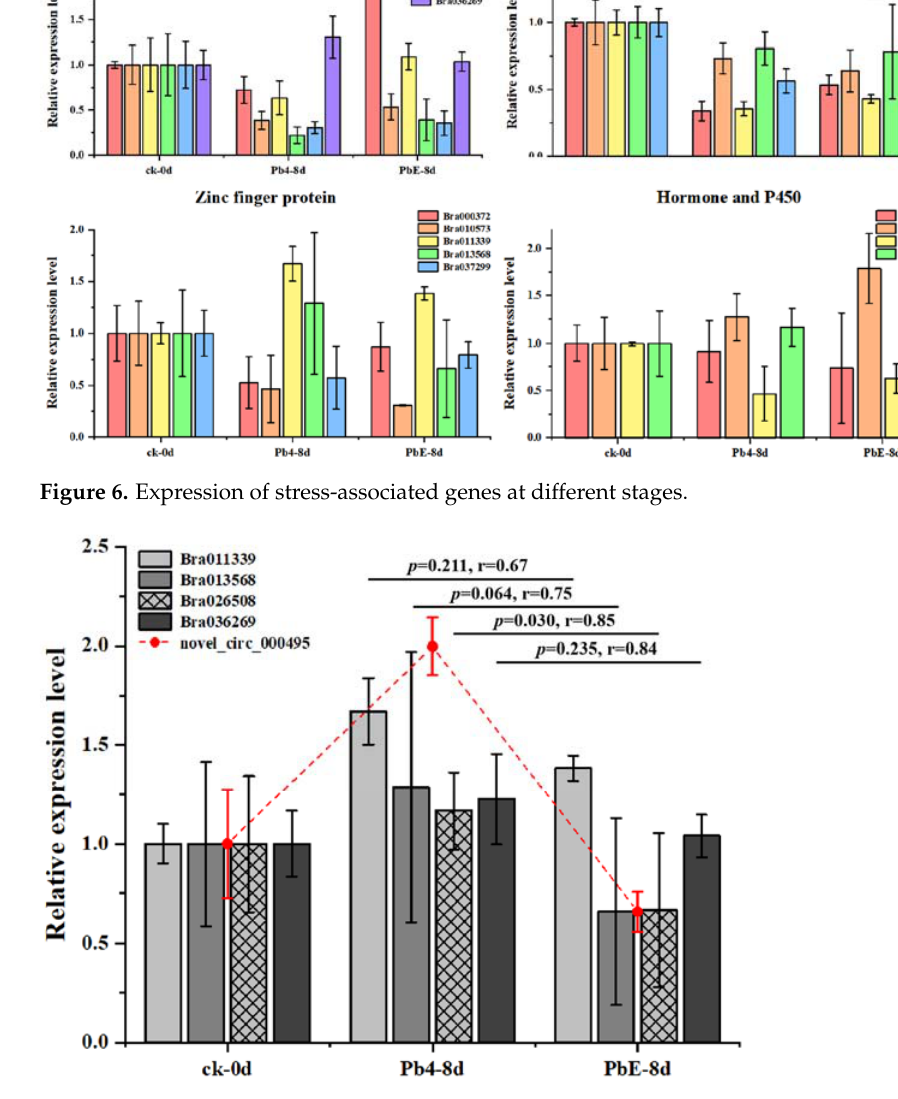
Figure 7. Relative expression level of target genes and circRNAs in roots.